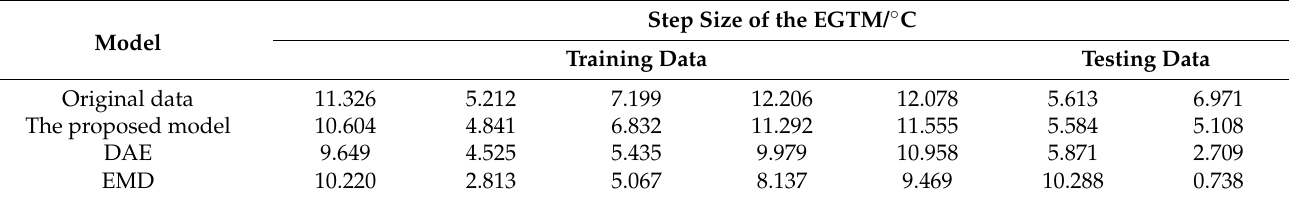
Table 13. Step of each segment of